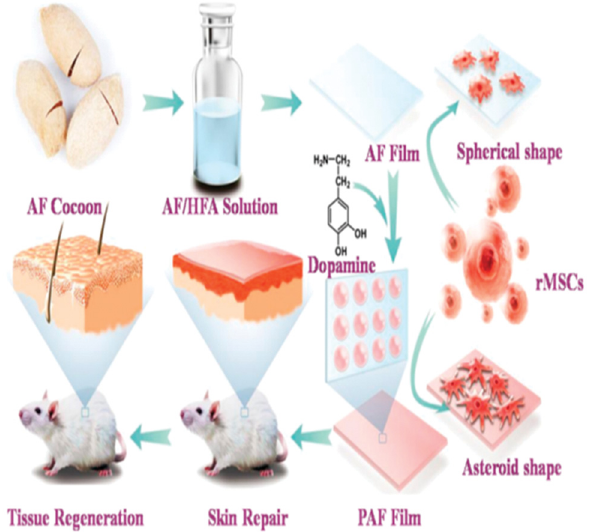
Figure 2: Preparation of PAF fi lm and its e ff ect on wound healing [ 106 ]